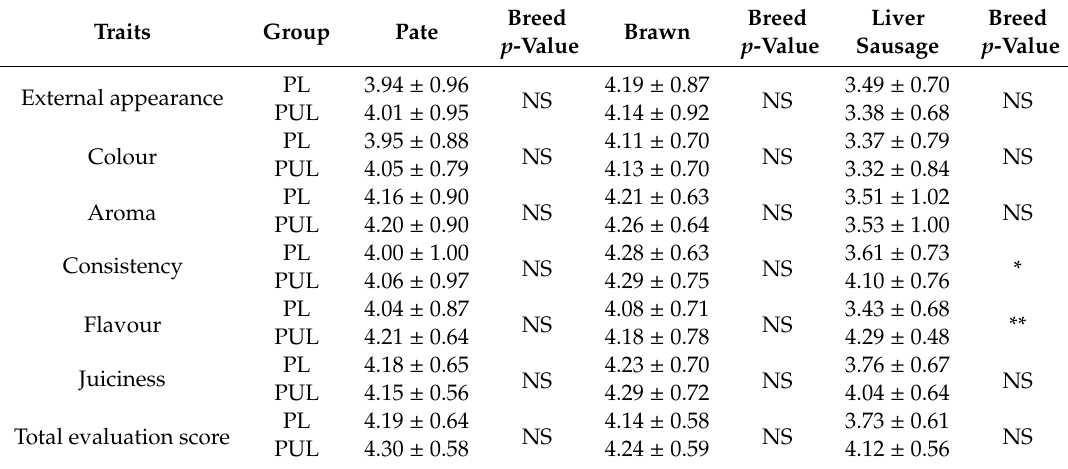
Table 5. Consumer evaluation of the o ff al products (mean ±